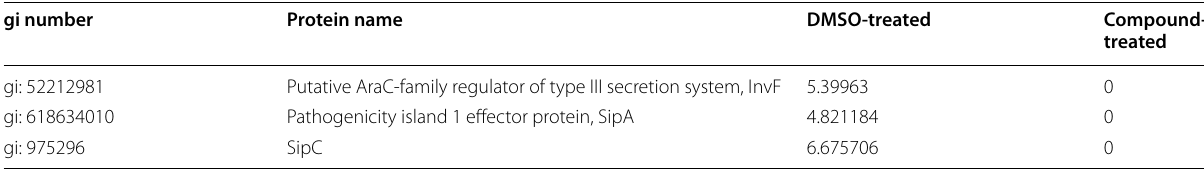
Table 3 Absolute selected proteins from quantitative proteomic analysis comparison between cellular proteins of S. Typhimurium in the presence of vehicle control (DMSO) or 100 μM compound gi